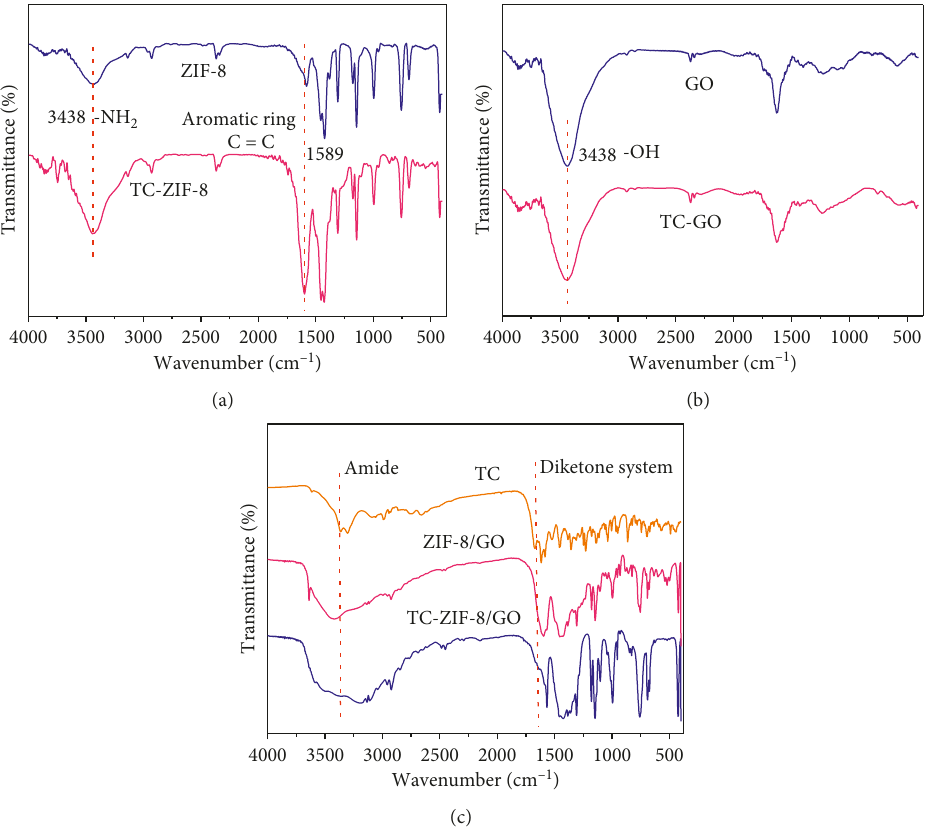
Figure 12: Infrared spectrum of the tested samples: (a) ZIF-8; (b) GO; (c)